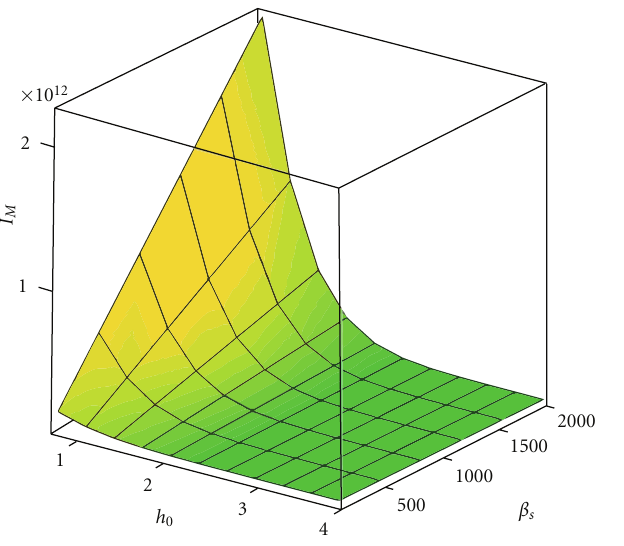
Figure 15: I M ( h 0 , a ) for β s = 500 and m = 2 × 10 − 5